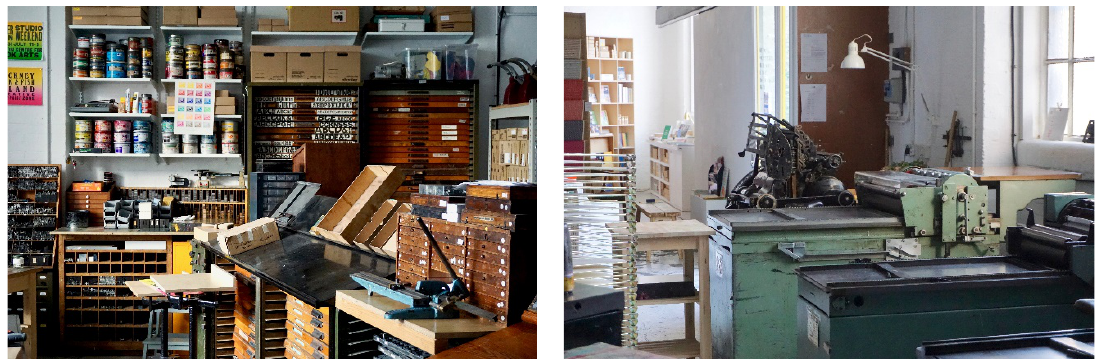
Figure 3. The London Centre for Book Arts: The studio was established in October 2012, becoming the first and only centre of its kind in the country. Photos courtesy of Ira Yonemura.